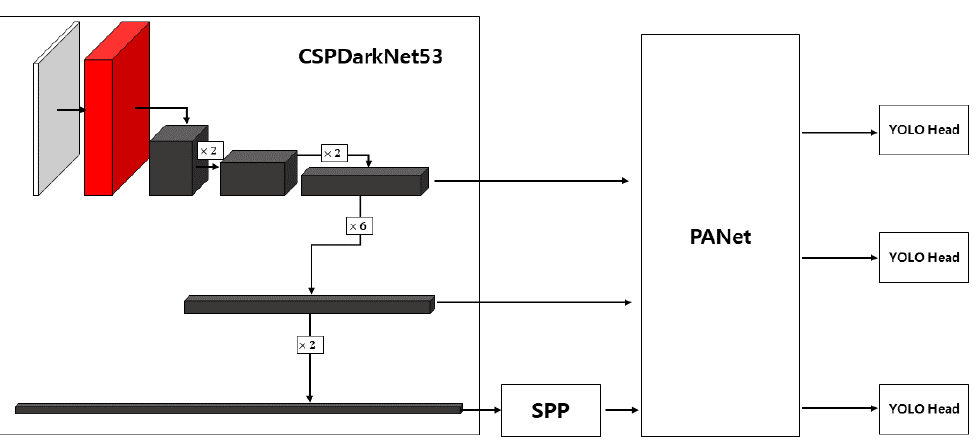
Figure 4. Structure of YOLOv4.